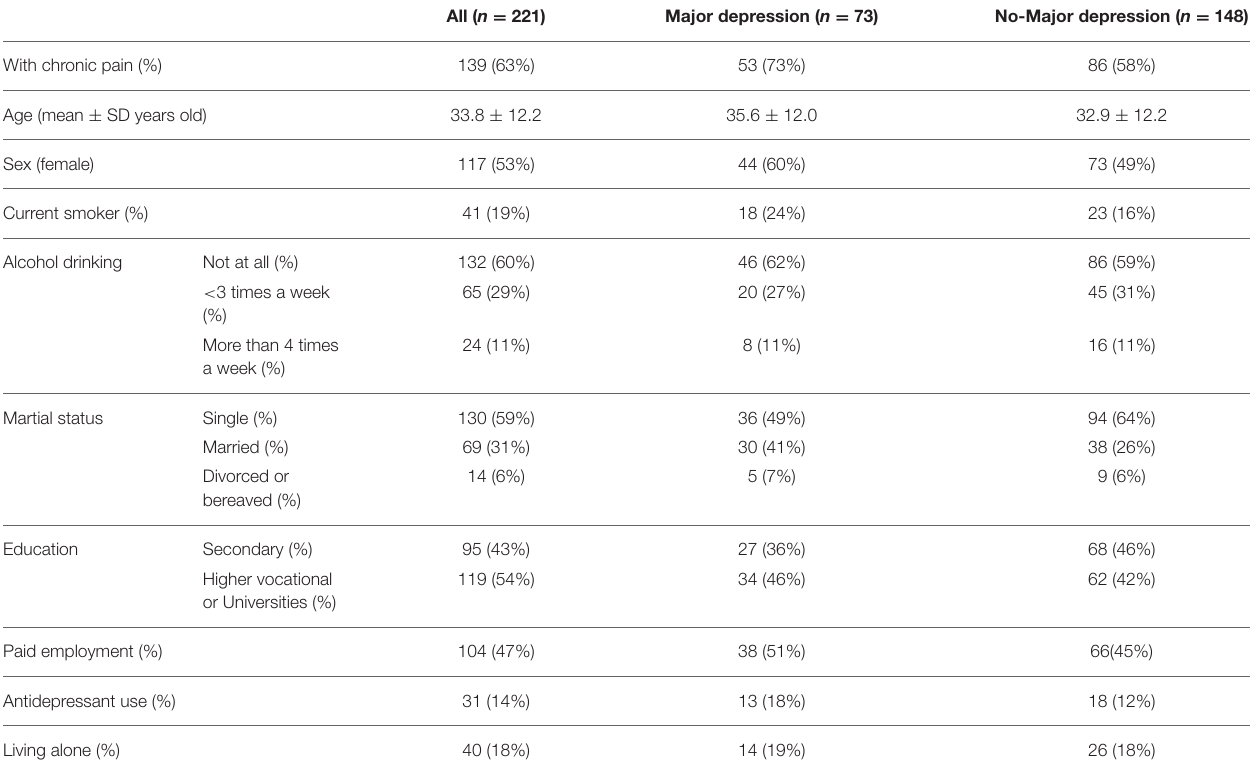
TABLE 1 | Demographic